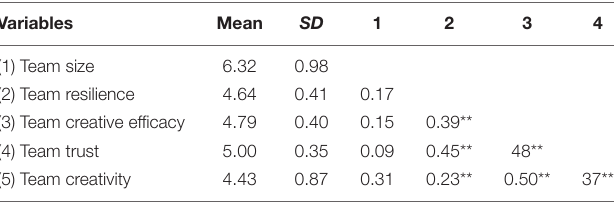
TABLE 1 | Descriptive statistics and correlations between